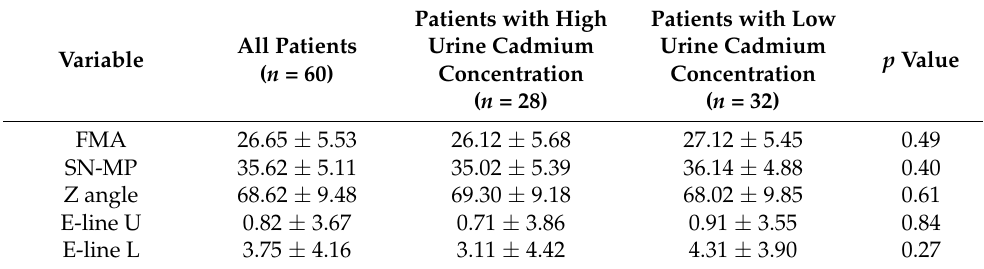
Table 6. Selected cephalometric facial measurements in orthodontic patients, stratified according to their urine cadmium concentrations as high or low ( n =